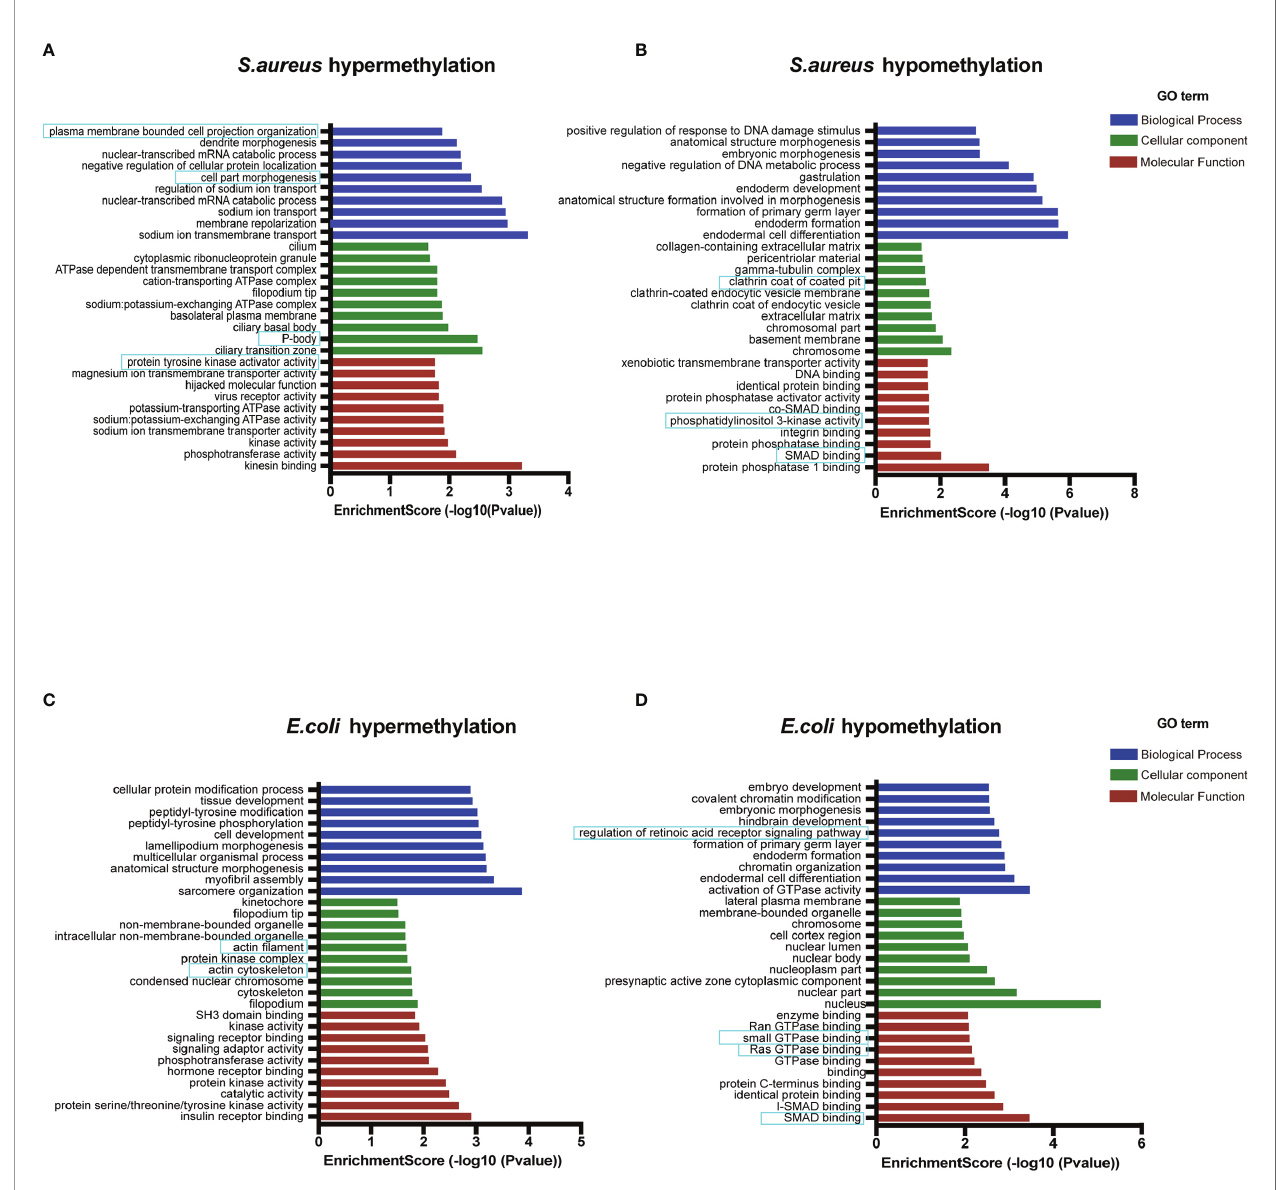
FIGURE 4 | Go enrichment analysis. (A) The top 10 GO terms enriched for the source genes of differential circRNA with hypermethylation and (B) hypomethylation in the S. aureus group. (C) The top 10 GO terms enriched for the source genes of differential circRNA with hypermethylation and (D) hypomethylation in the E. coli group (the predicted GO pathways in the blue box were related to in fl ammation, apoptosis, and